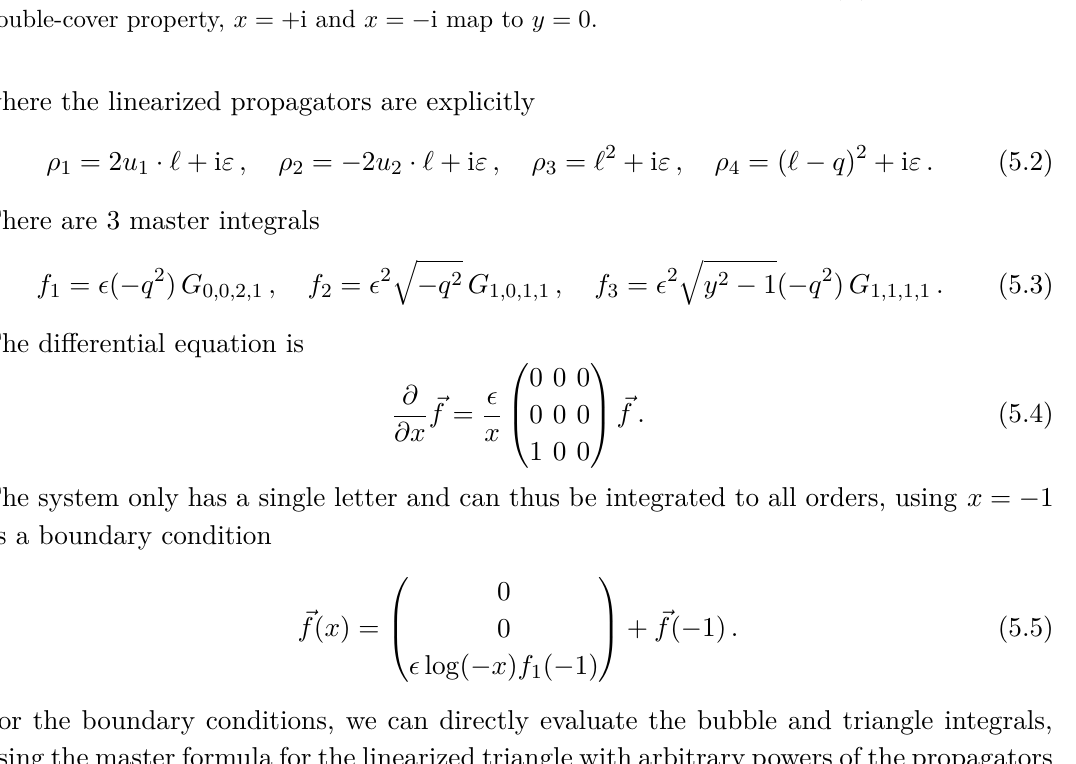
Figure 8. Kinematics in x and y space. The x plane is a double cover of the y plane, i.e. the two points x and 1 /x map to the same point y , we therefore focus on points inside the unit disc | x | ≤ 1 . Physical s -channel scattering (green region) corresponds to y > 1 and Im( y ) = 0 + , i.e. 0 < x < 1 and Im( x ) = 0 − . Physical u -channel scattering (red region) corresponds to y < − 1 and Im( y ) = 0 − , i.e. − 1 < x < 0 and Im( x ) = 0 + . There is also a Euclidean region connecting the two for real − 1 < y < +1 which corresponds to points on the unit circle | x | = 1 . Due to the double-cover property, x = +i and x = − i map to y = 0